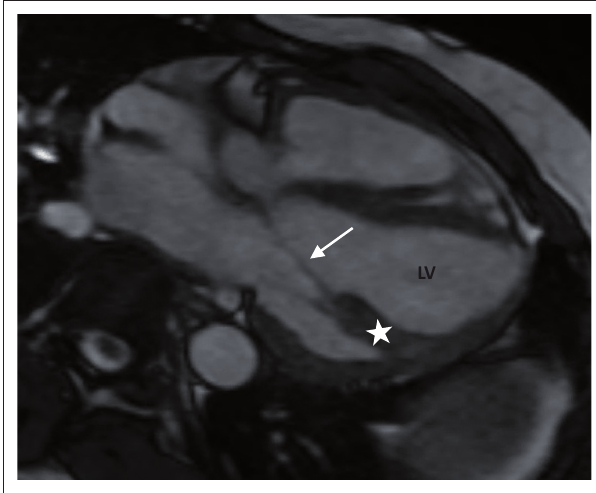
FIGURE 10: Four-chamber cine SSFP image demonstrates a thickened single papillary muscle (*) in the left ventricle (LV) with all the tendinous cords (white arrow) attaching to this single papillary muscle.